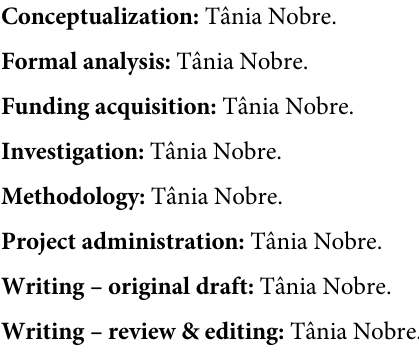
S1 Fig. Bactrocera oleae maximum likelihood reconstruction. S1 Table. Primers used to amplify Bactrocera oleae mitochondrial DNA segments analysed in this study. S2 Table. Sequence variability having the Bactrocera oleae mitochondrion, complete genome AY210702 as reference. S3 Table. Mitochondrial haplotypes shared by different specimens. S1 File. 16S variable sites and haplotype